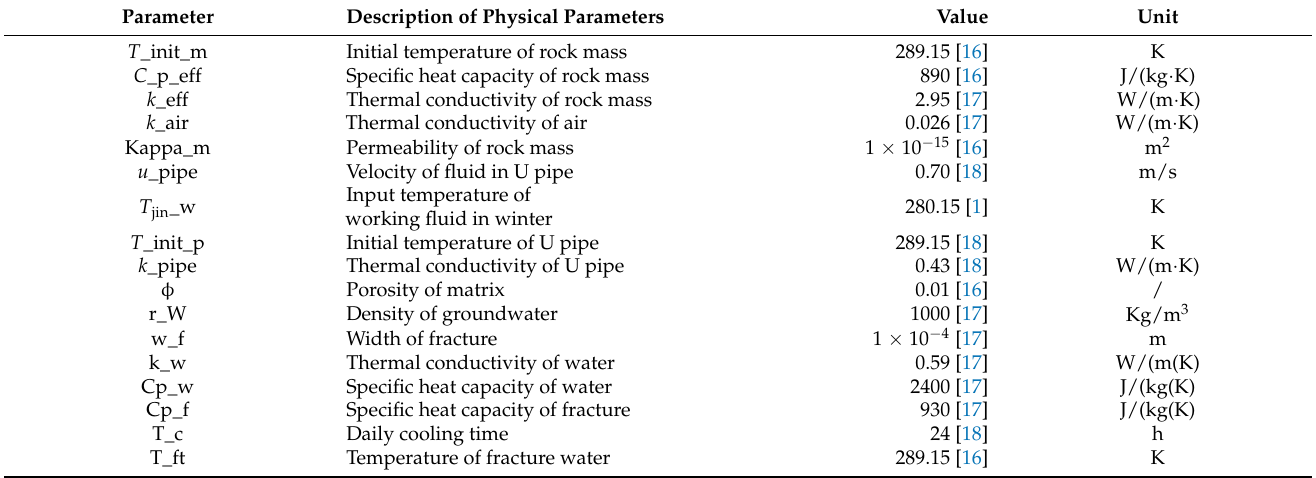
Figure 7. Layout of the heat exchange pipes in the model. (A) water inlet point; (B) water outlet point; The number values are the location of holes. The number values are the location of holes. Table 1. Definition of the physical parameters in the numerical